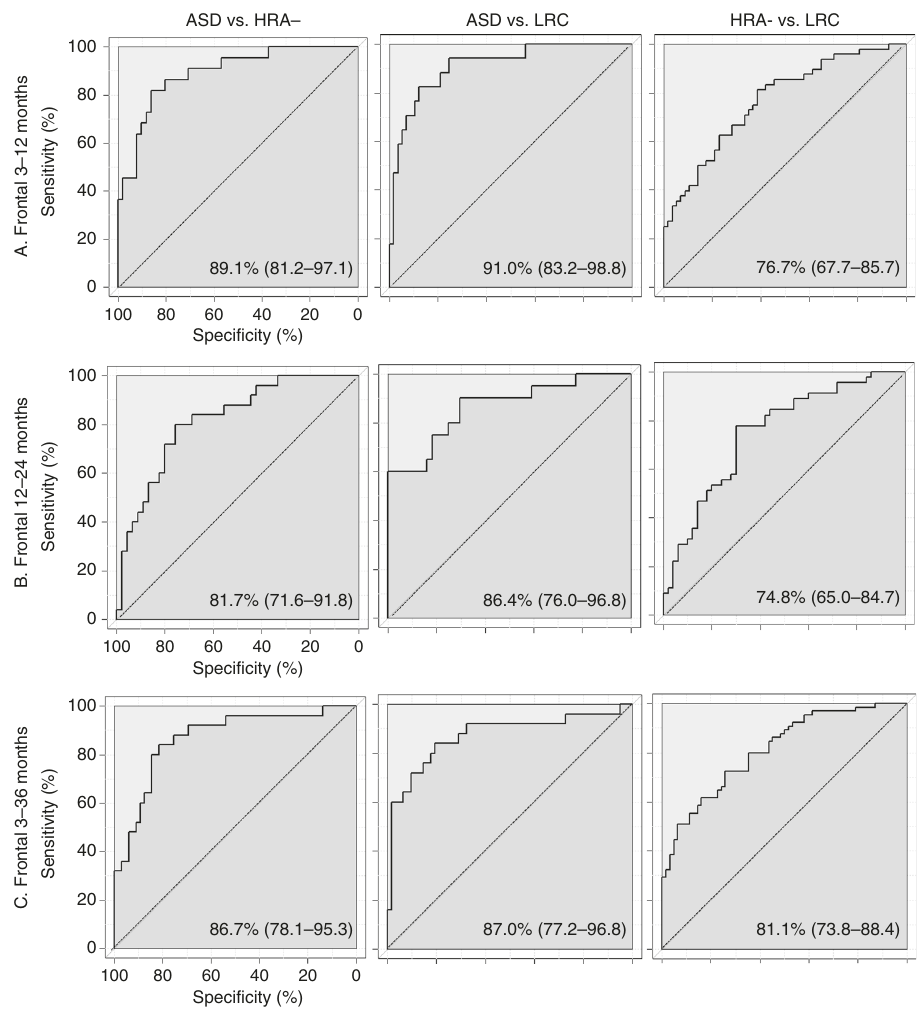
Fig. 1 ROC curves. Receiver operating characteristic (ROC) curves for each frontal EEG model comparing pairs of ASD outcome groups for each developmental window ( a – d ). Area under the curve and their 95% con fi dence intervals are given in the right corner of each ROC curve. Dashed black lines indicate chance performance. Solid black line indicates each model ’ s